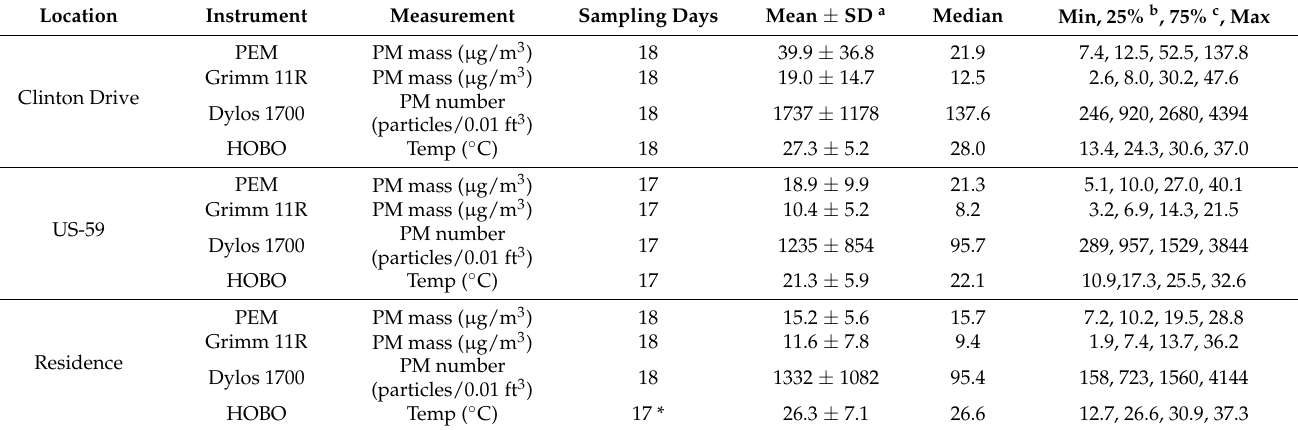
Table 1. Summary of data obtained from the Dylos, Grimm, and HOBO by